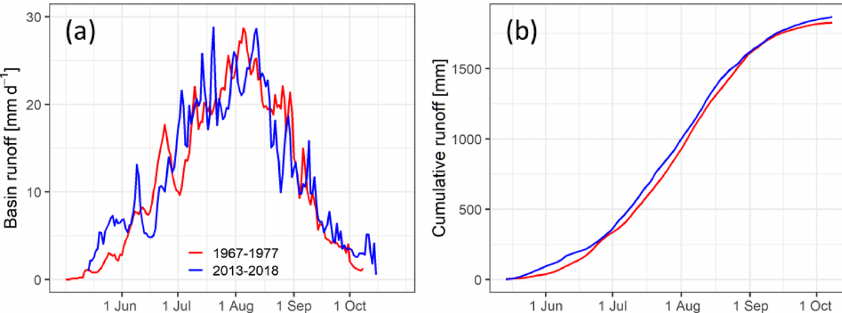
Figure 16. Runoff data: (a) daily basin streamflow, expressed as a depth of runoff per day, averaged over the historical (1967–1977) and recent (2013–2018) periods; (b) cumulative annual depth of runoff averaged over the same periods.